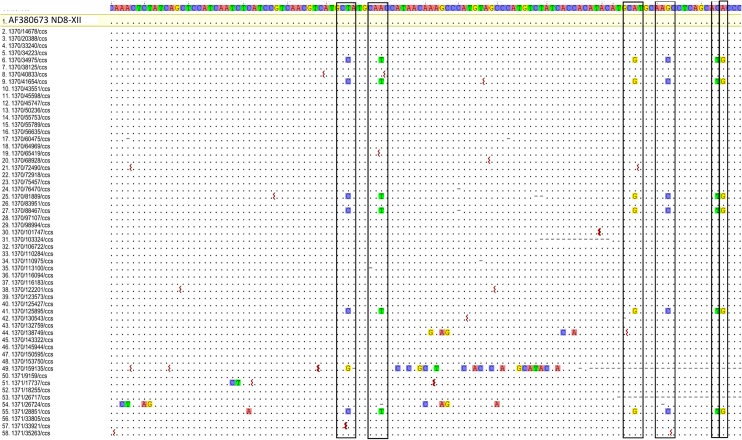
Conserved patterns of nucleotide changes.Multiple alignment of 58 CCS sequences which assembled to the minicircle, mc54, which encodes gND8-XII. The minicircle consensus sequence from nt 550–664 is at the top. Dots indicate matches and squiggles indicate deletions. Dashes indicate gaps. Columns with conserved single nucleotide mutations (T to C, A to T, A to G, G to C, C to T, A to G) in 6 of the CCS sequences at identical relative positions are boxed.